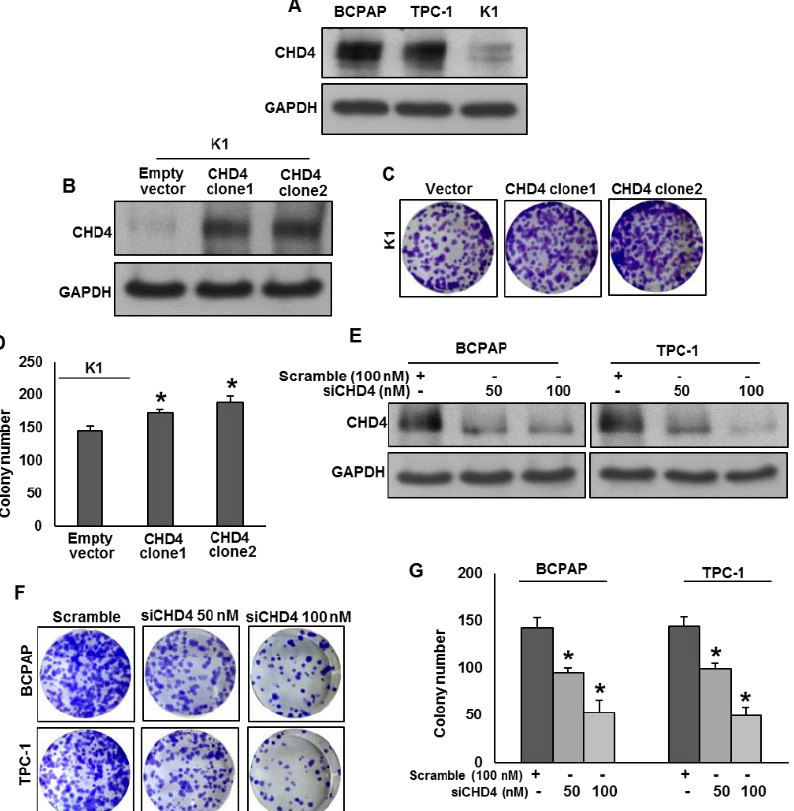
Figure 2. CHD4 promotes PTC cell growth in vitro. ( A ) Basal expression of CHD4 in PTC cell lines. Proteins were isolated from three PTC cell lines and immunoblotted with antibodies against CHD4 and GAPDH. ( B ) Forced expression of CHD4 in low expressing cells. K1 cells were transfected with either empty vector or CHD4 cDNA and overexpression was confirmed by immunoblotting. ( C , D ) Forced expression of CHD4 increases clonogenicity. K1 cells were transfected with either empty vector or CHD4 cDNA. After 48 h, cells were seeded at a density of 500 cells per well in 6-well plate, and grown for an additional 10 days, then stained with crystal violet and colonies were counted. ( E ) Knockdown of CHD4 in expressing cells. PTC cells were transfected with scrambled siRNA and CHD4 siRNA (50 and 100 nM) for 48 h. Knockdown was confirmed by siRNA. ( F , G ) Knockdown of CHD4 decreases clonogenicity. PTC cells were transfected with scrambled siRNA and CHD4 siRNA (50 and 100 nM). After 48 h, cells were seeded at a density of 500 cells per well in 6-well plate, and grown for an additional 10 days, then stained with crystal violet and colonies were counted. Data presented in the bar graphs are the mean ± SD of two independent experiments. * Indicates a statistically significant difference compared to control with p < 0.05.